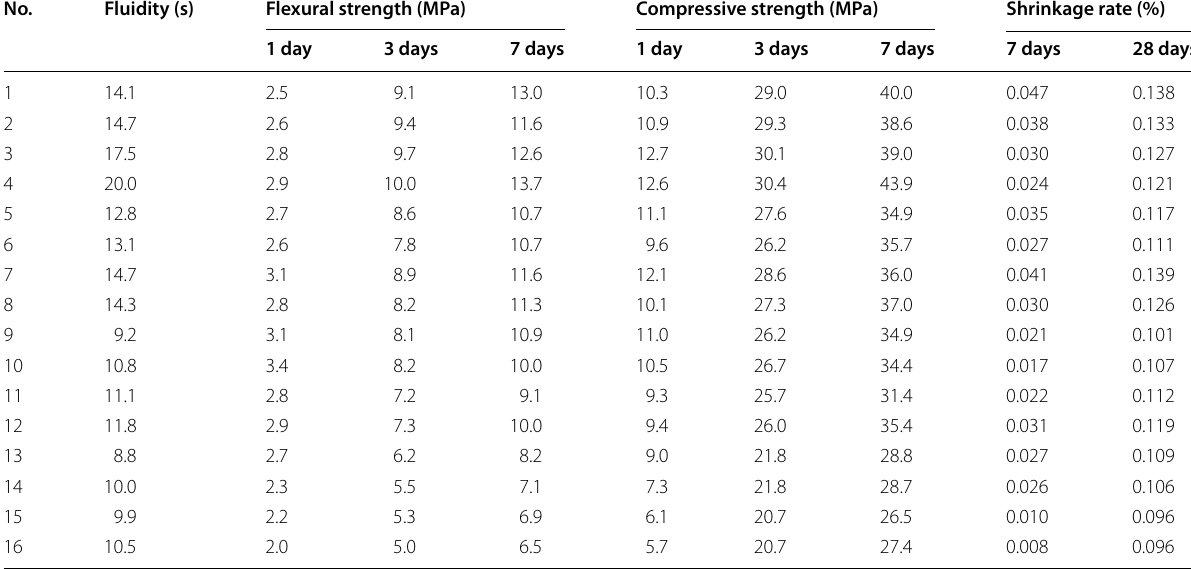
Table 7 Result based on the test scheme (Ren et al., 2021a, 2021b) No.